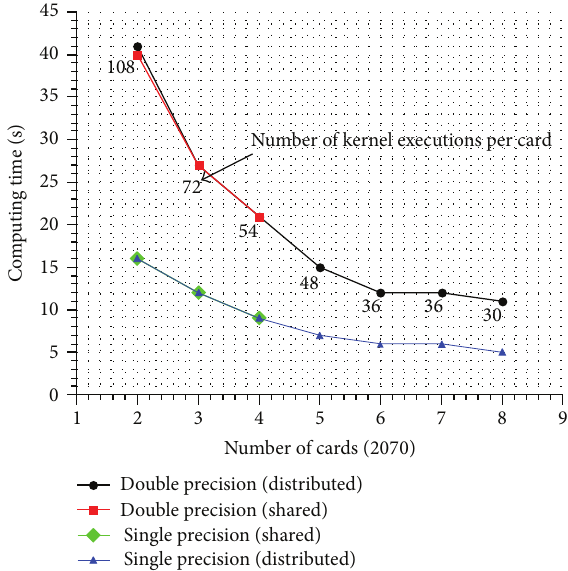
Figure 13: Execution time obtained using shared and distributed graphics cards, in double and single precision. We can see that MPI is not introducing overhead in the computing time.